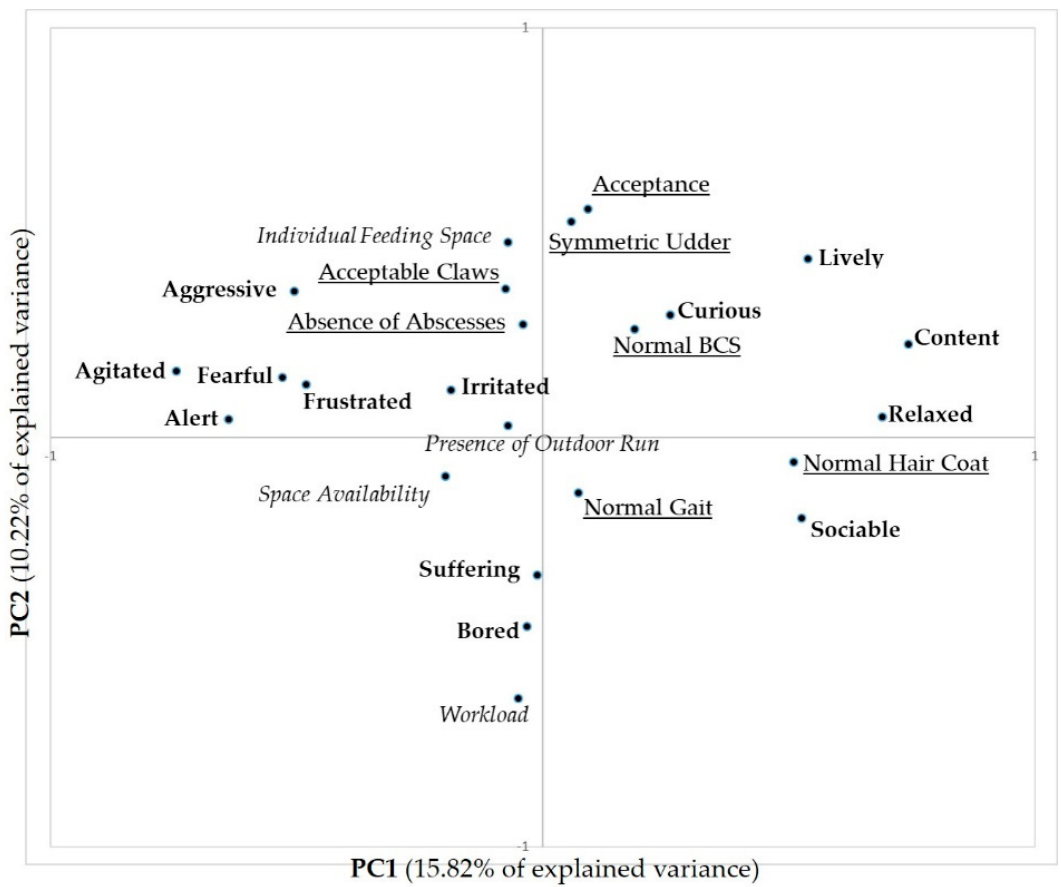
Figure 1. Loadings of Qualitative Behaviour Assessment descriptors (in bold), other quantitative animal-based measures (underlined), and resource-based measures (in italics) along the first two PCs for the 60 farms.